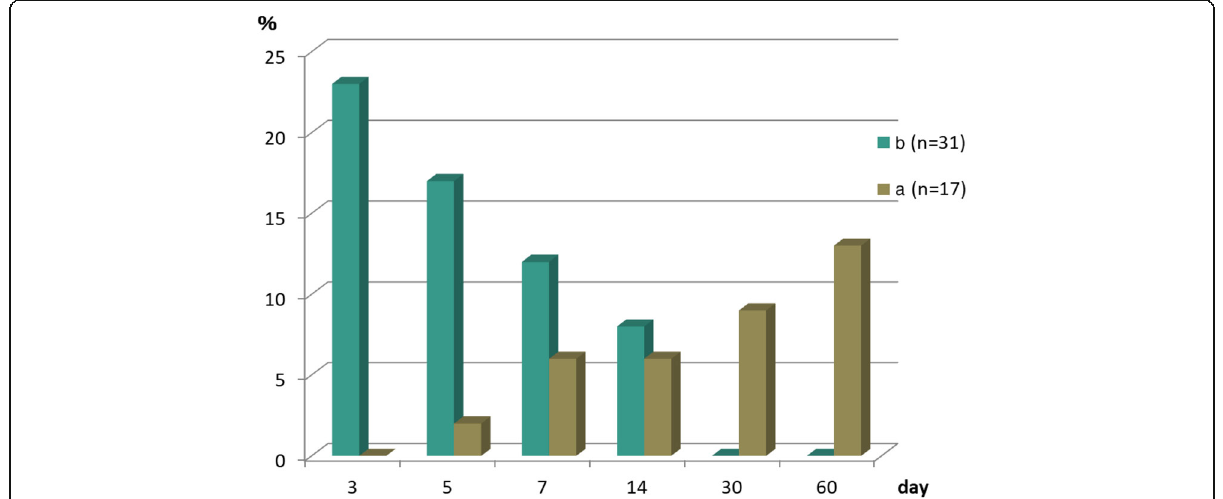
Figure 7 Enquired days for early training and packing load of donkeys in Afar communities. a indicates the number of responses in Area A. b indicates the number of responses in Area B. There is different between A and B significantly ( χ 2 test, p <